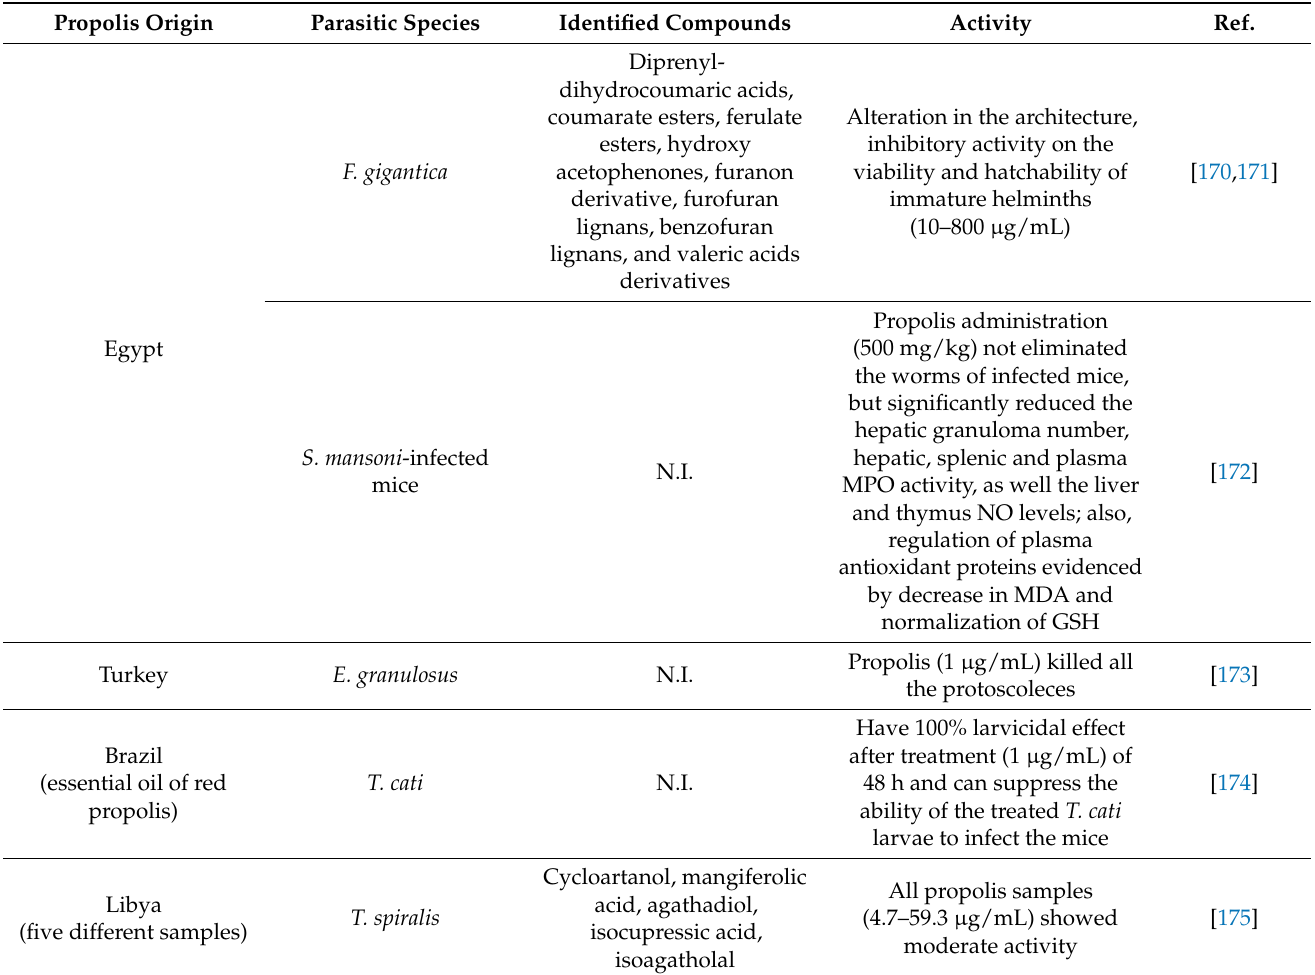
Table 16. Anthelmintic activity of propolis and its chemical